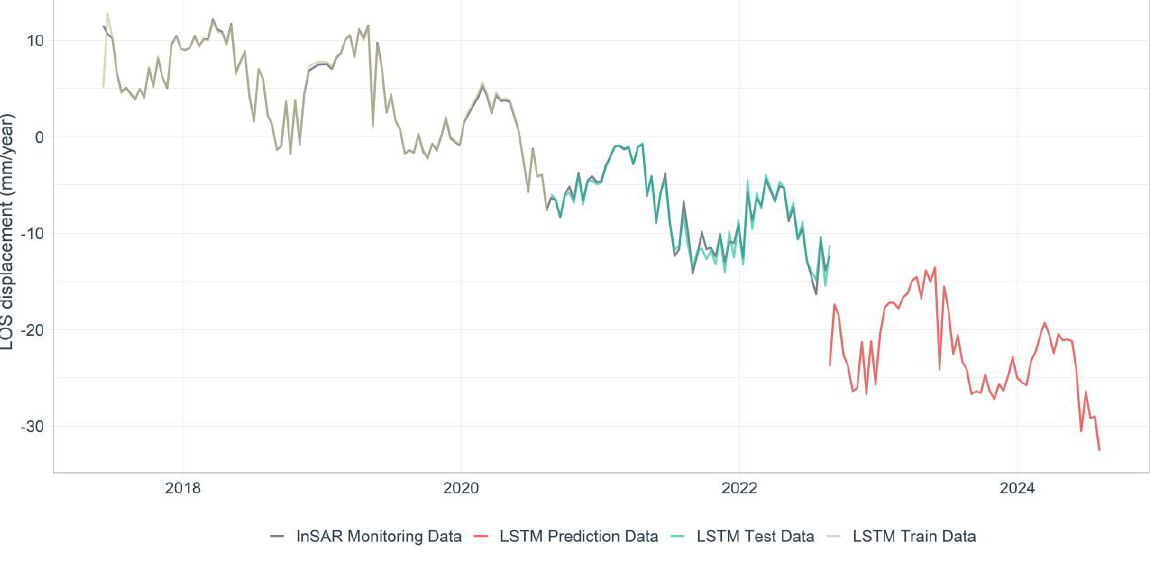
Figure 6 . Time series of monitored and predicted displacements. The vertical axes show the LOS displacement velocity